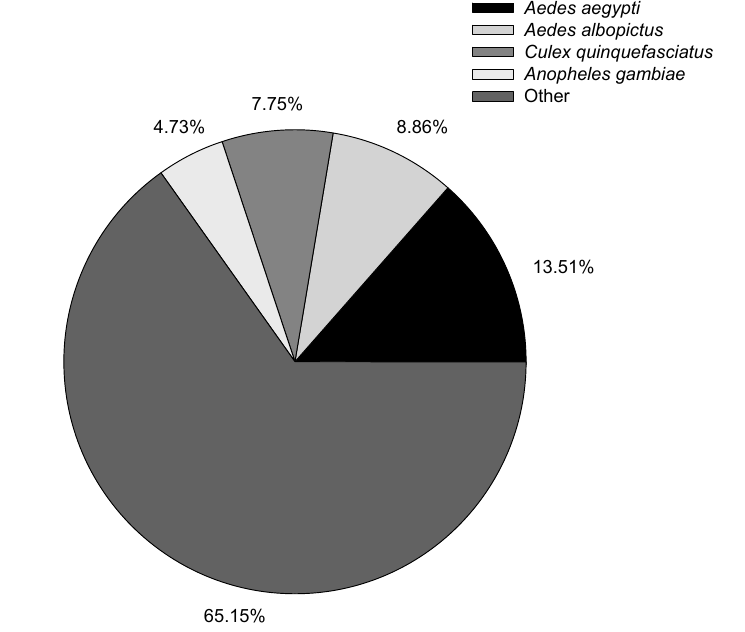
Figure 2. Distribution of annotated species.